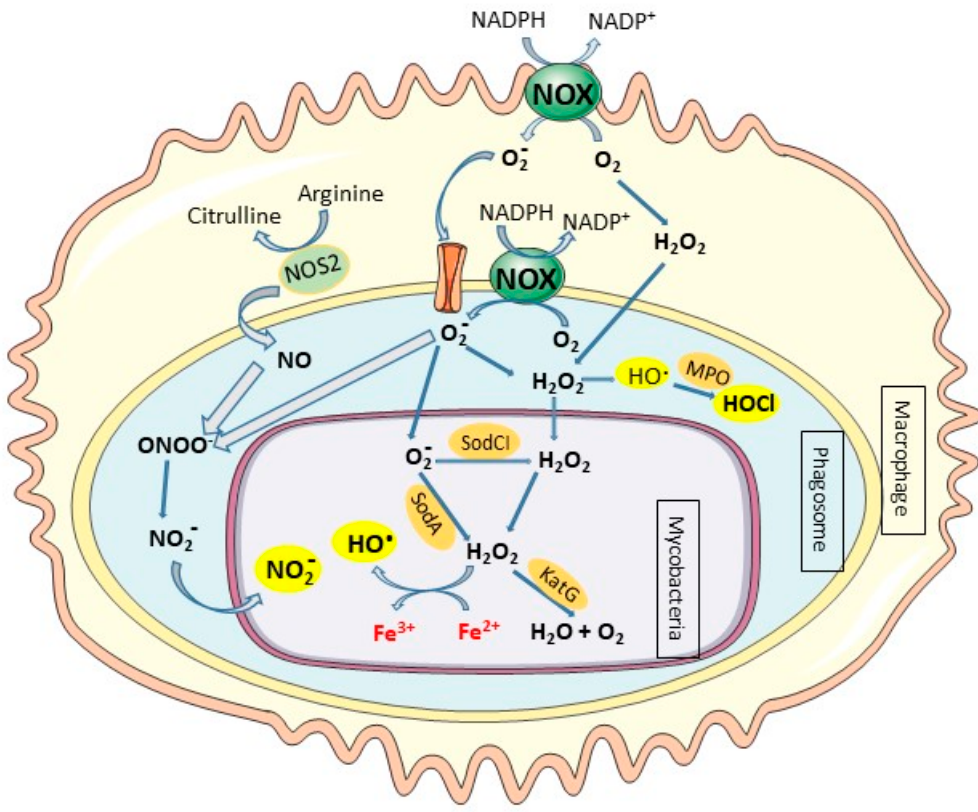
Figure 2. Series of reactive oxygen species generated in response to intracellular mycobacteria infection. Macrophages and neutrophils produce reactive oxygen species to kill intracellular microbes in a series of reaction which can be initiated by the conversion of NADPH to NADP + via the NADPH oxidase (NOX) and the production of superoxide O 2 − in presence of O 2 . O 2 − can enter in the phagosome and later in the mycobacteria through porins or crosses the outer membrane that is partially permeabilized by antimicrobial peptides. O 2 − is a substrate for superoxide dismutase (SodCI, SodA) to produce H 2 O 2 which can freely di ff use across membranes. The hydroxyl radical (OH • ) is produced from H 2 O 2 and superoxide via Fenton reaction. Mycobacteria produce the catalase KatG to detoxify H 2 O 2 . The production of NO from arginine metabolism via nitric oxide synthase (NOS2) can generate nitric oxide which in presence of O 2 − produce ONOO − and NO 2 − , which present some toxic proprieties against mycobacteria.